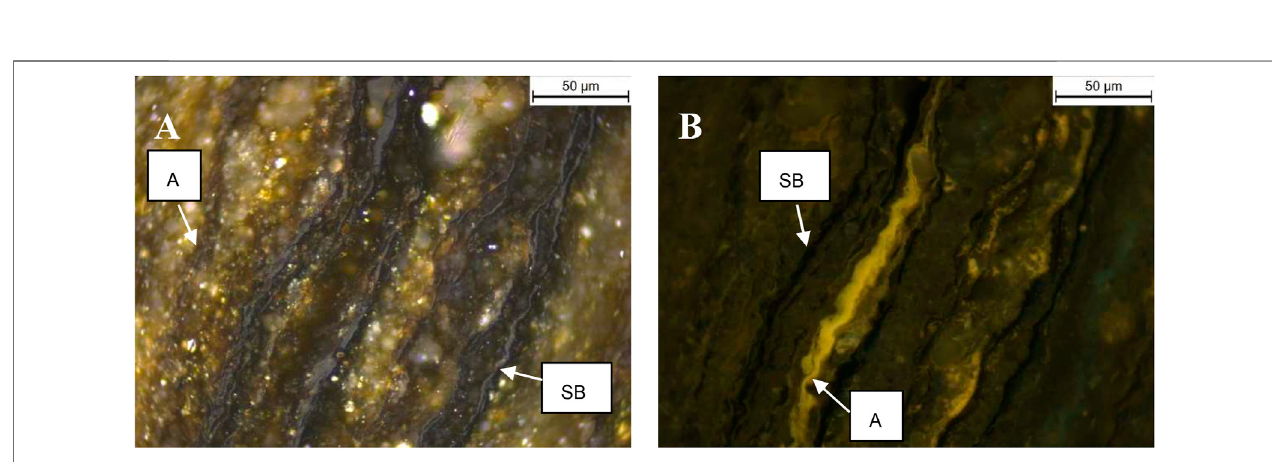
FIGURE 7 | Representative examples of photomicrographs of solid bitumen and alginite enriched Mahogany Shale [ (A) , re fl ected light, oil-immersion; ( B ) , fl uorescent light]. Abbreviations: SB – solid bitumen, A – alginite.